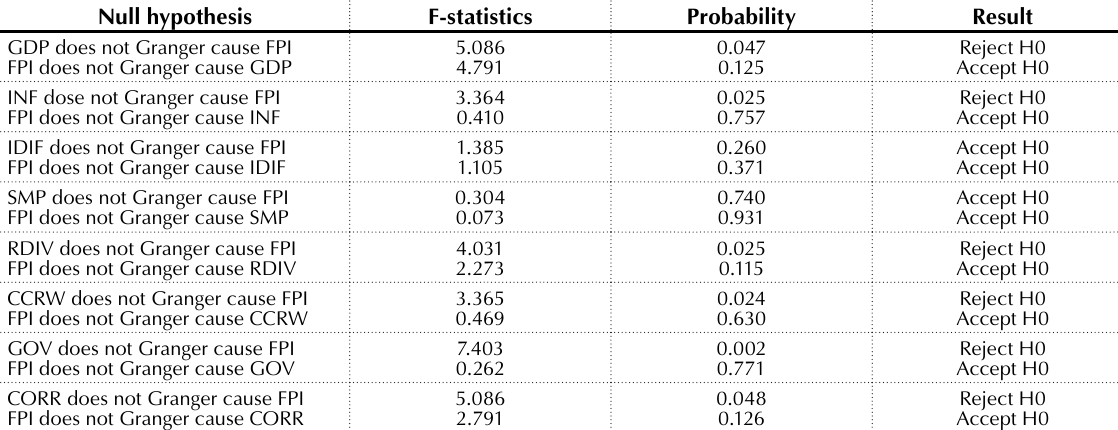
Table 5. Results of Granger causality